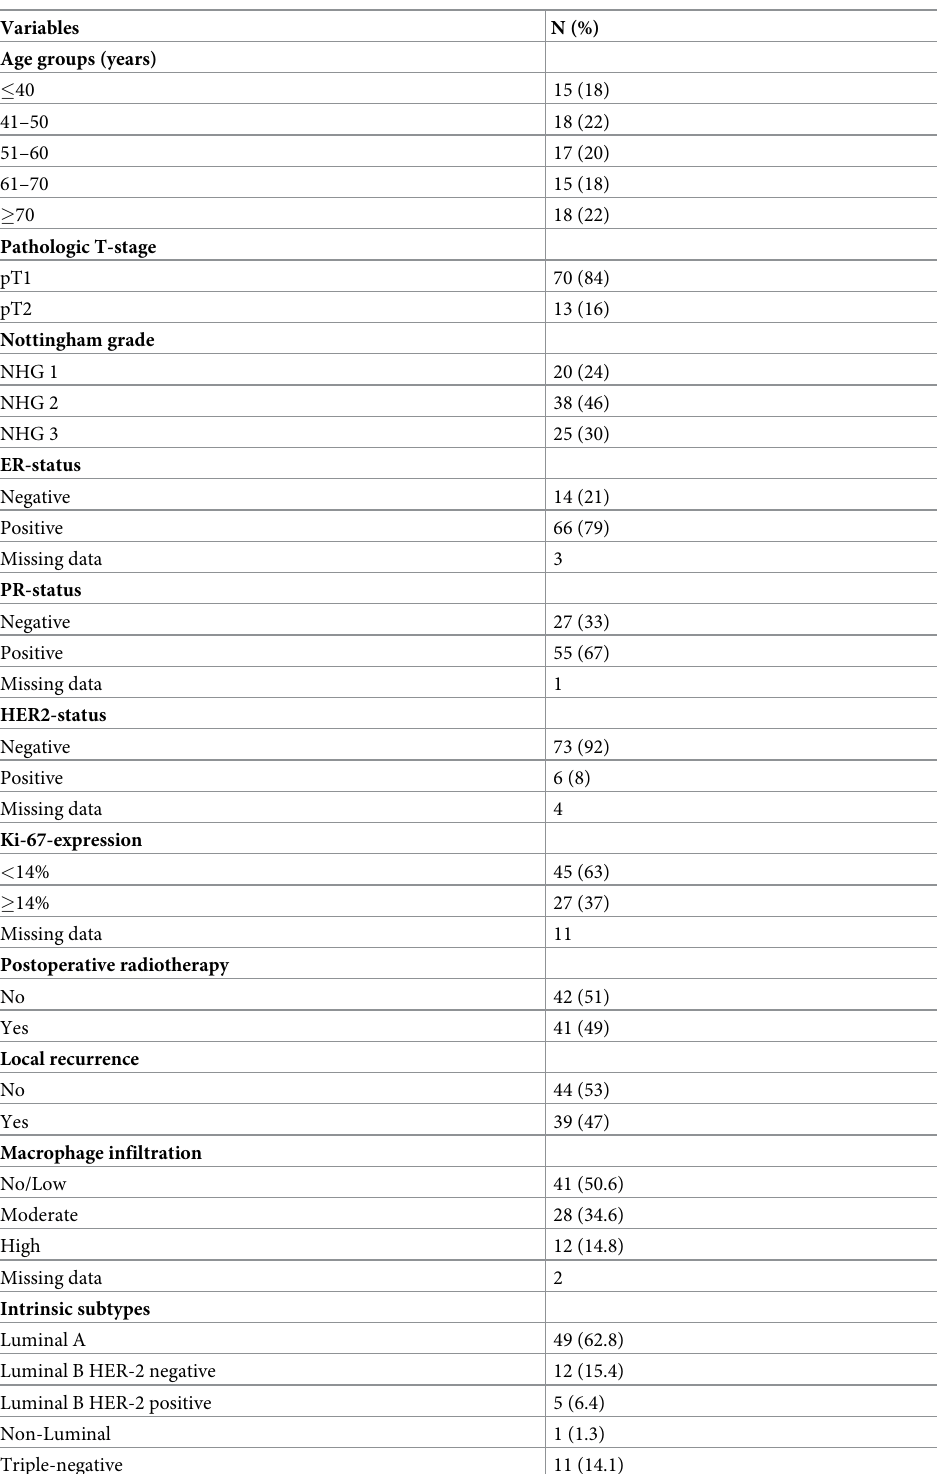
Table 1. Patient